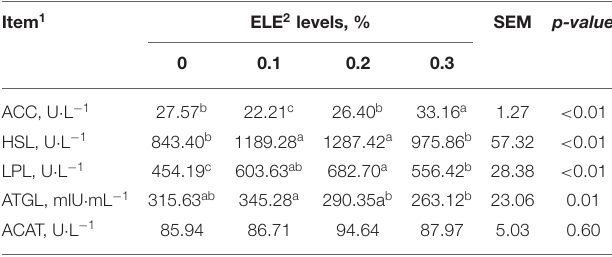
TABLE 7 | Effects of different levels of ELE on key enzyme activity-related lipid metabolism in backfat tissue of growing–finishing